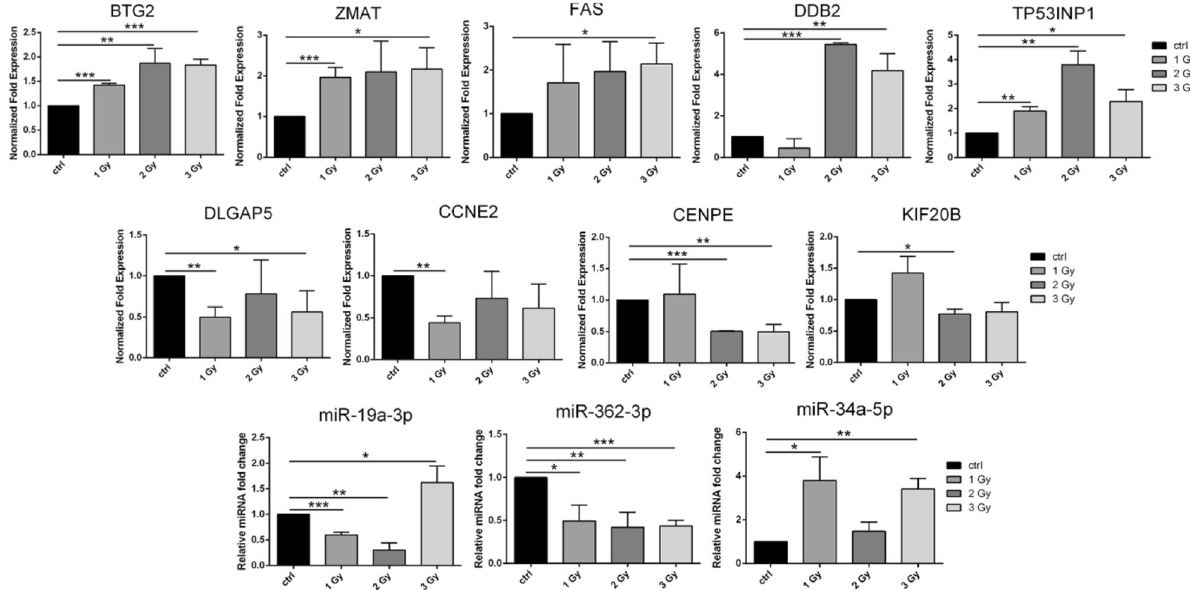
Figure 5. Expression of the most upregulated and downregulated mRNAs were: BTG2 , ZMAT , FAS , DDB2 , TP53INP1 , DLGAP5 , CCNE2 , CENPE , KIF20B and microRNAs: hsa-miR-19a-3p, hsa-miR-362-3p, hsa-miR- 34a-5p were validated by